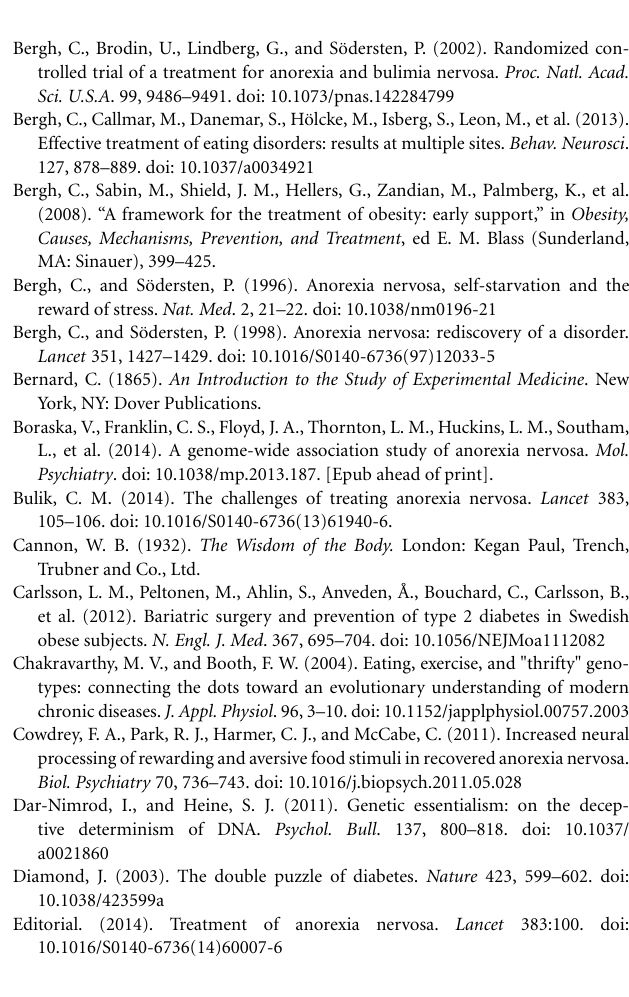
women were challenged to eat a lunch at an increased (ER + ) or decreased (ER − ) speed. The end of the uninterrupted lines indicates the point in time when the subjects stopped eating; the dashed continuation of the line indicates the extrapolation of the modeled curve. (C) Food intake at lunch in 13 women and 9 men in their un-deprived condition (Ctr), after omitting dinner the day before lunch without ( − Fasting) or with ( − Feedback) visual feedback on how to eat. We thank Elsevier for permission to reproduce (A,C) from Zandian et al. (2011) and Springer Science + Business Media for permission to reproduce (B) from Ioakimidis et al.